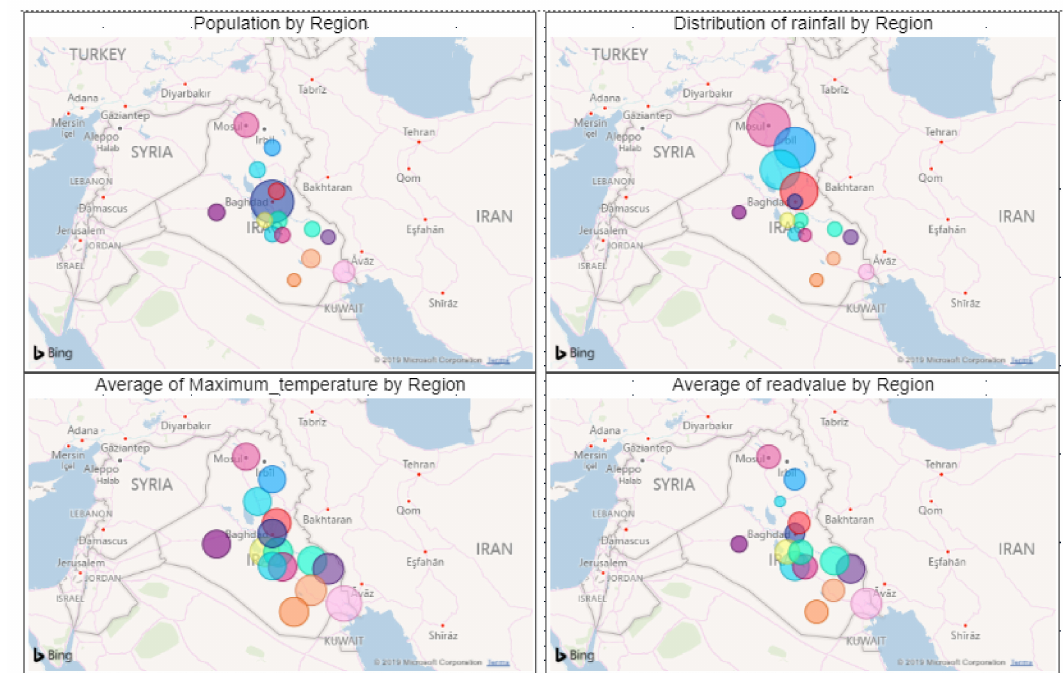
Figure 8. Distribution of Population Density, Average of Rainfall Intensity, An Average of Maximum Temperature, and Consumption Read Value Over Different Iraqi